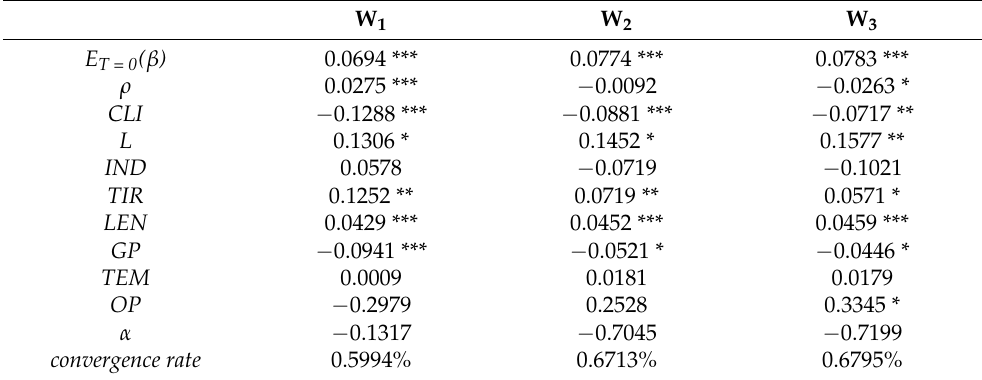
Table 4. Conditional convergence of natural gas